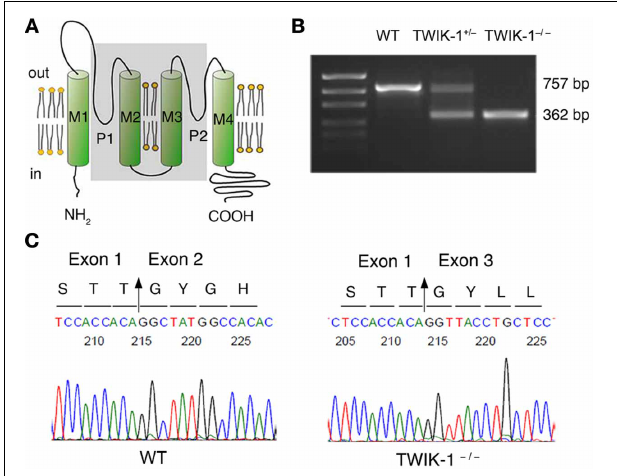
FIGURE 1 | TWIK-1 gene knockout mice. (A) Schematic illustration of the targeted exon 2 deletion in TWIK-1 gene. Exon 2 encodes the two ion conducting pores (P1, P2), and the transmembrane domain 2 and 3 (M2, M3) (all in shadow). (B) RT-PCR amplification targeted on the axon 2 of TWIK-1 gene was performed with the mRNAs extracted from hippocampus of WT, heterozygote (TWIK-1 + / − ) and TWIK-1 − / − mice, that yielded the anticipated products as indicated. (C) Sequencing analysis from the PCR products from (B) confirmed an anticipated deletion of exon 2 in TWIK-1 − / − mouse, which encodes 132 amino acids in the position 119–250 of TWIK-1